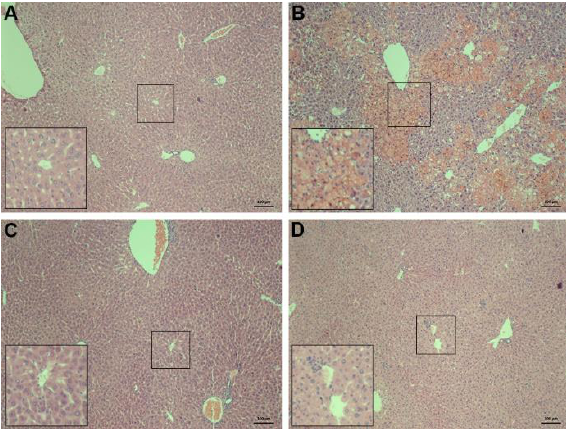
Figure 3. The histological observation of liver injury. After given APAP for 4 h, the livers were removed, fixed, sectioned (5 μm), and processed for hematoxylin and eosin (H&E) staining. Typical images were chosen from each experimental group ( n = 6). ( A ) Vehicle control, ( B ) APAP (400 mg/kg), ( C ) APAP (400 mg/kg) + AS-IV (20 mg/kg), ( D ) APAP (400 mg/kg) + AS-IV (40 mg/kg) (magnification × 100).